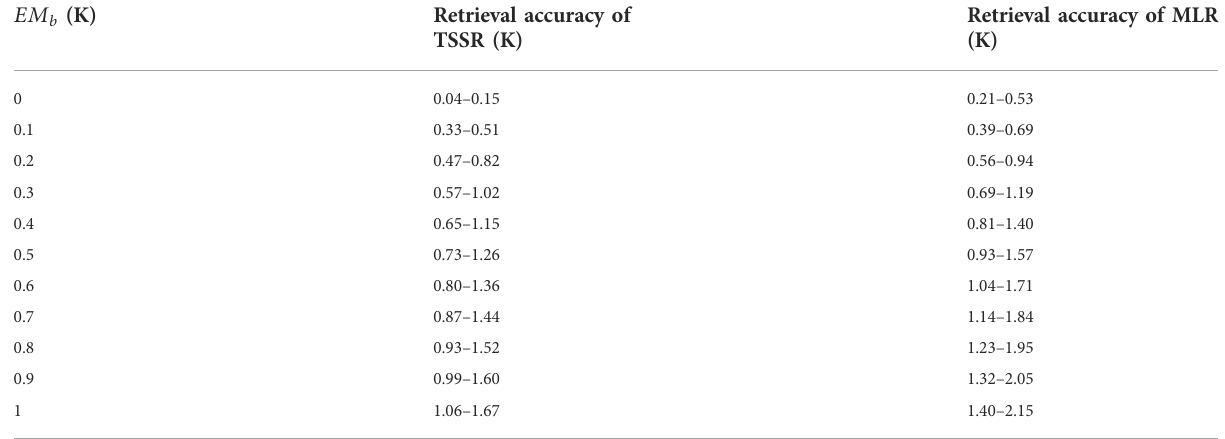
TABLE 1 SST retrieved with different dilation values. EM b (K) Retrieval accuracy of